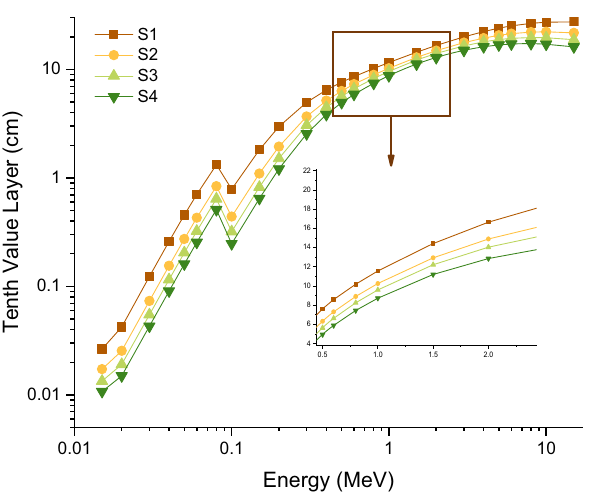
Figure 9: Variation of TVL ( cm ) with photon energy ( MeV ) for all S1 – S4 glasses.